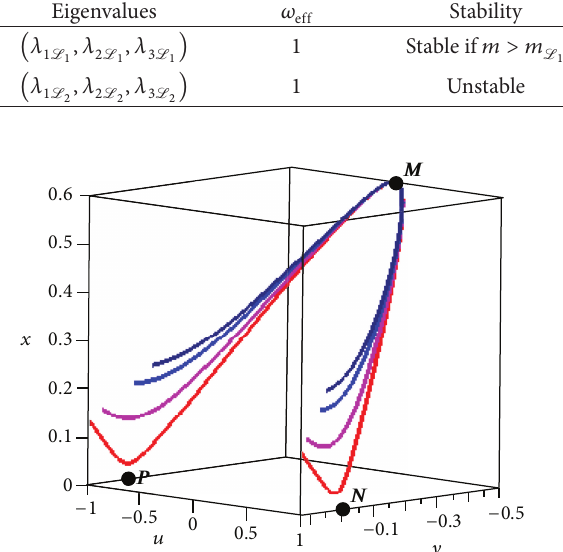
Table 3: Location, eigenvalues, and dynamical characters of the critical lines. Note that 𝑚 L